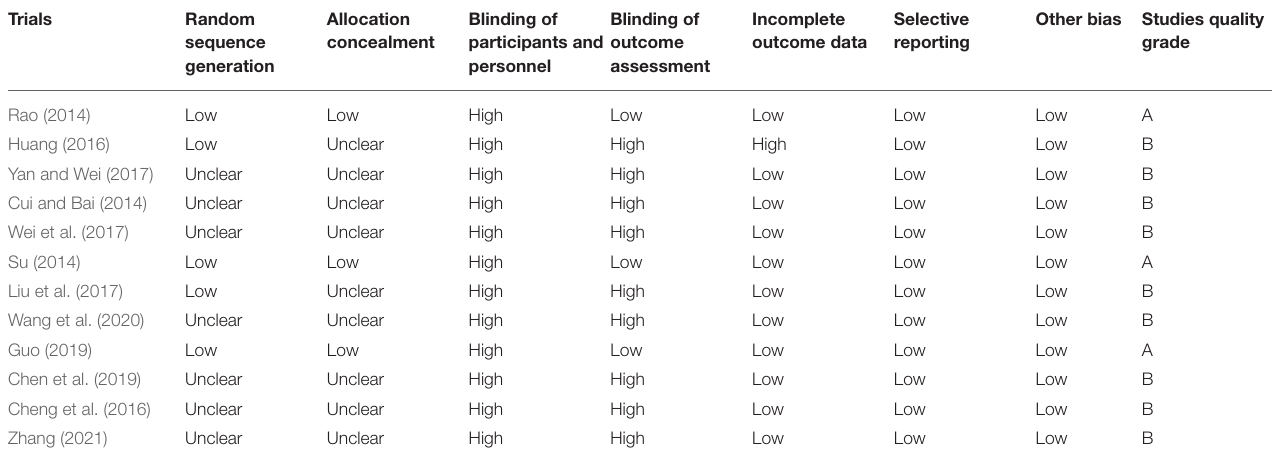
TABLE 2 | Risk of bias